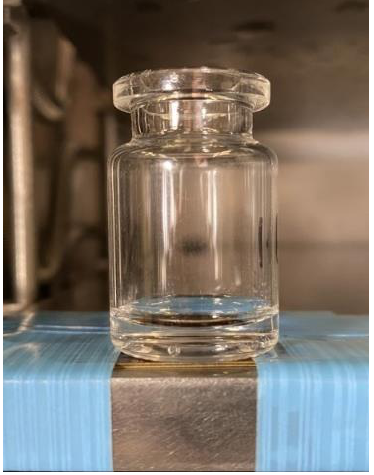
Figure 6. Position of heat flux sensor FHF03 in the freeze